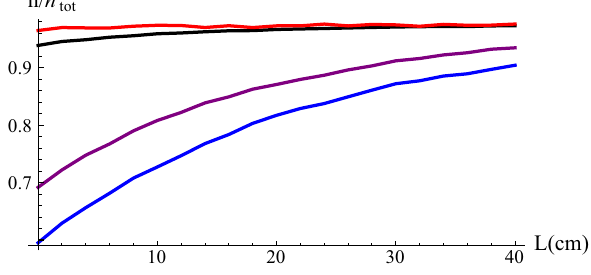
Fig. 9 The fraction of neutrons that are not lost to neutron bounce- back, in the case of a 250 MeV proton beam, as a function of the size of the gap between the target and the converter. The red, black, purple and blue curves correspond to a Bi target with a LiOD · D 2 O converter, a Pb target with a LiOD · D 2 O converter, a W target with a LiOD converter and a W target with a LiOD · D 2 O